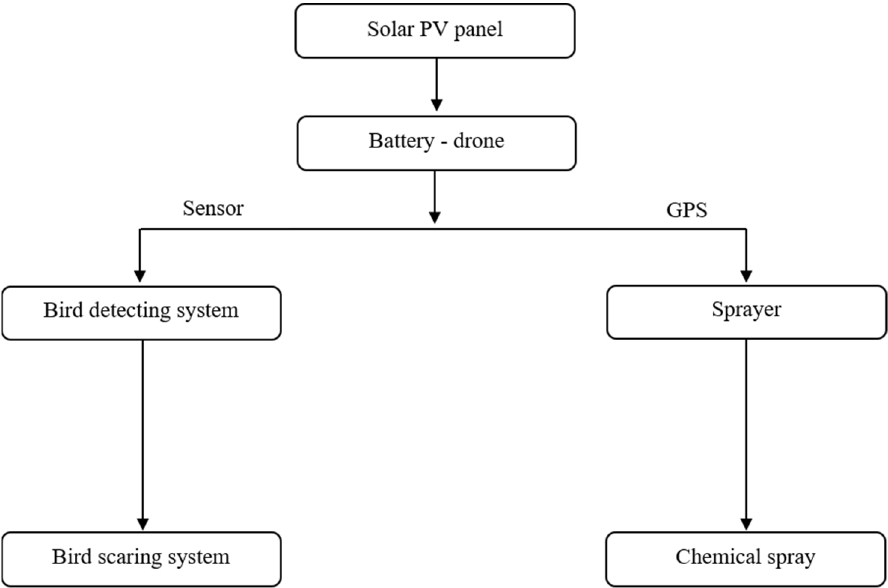
Figure 7. An integrated approach: solar-powered drone for bird scaring and spraying operations. Figure 7. Thrust areas for PV-powered plant protection